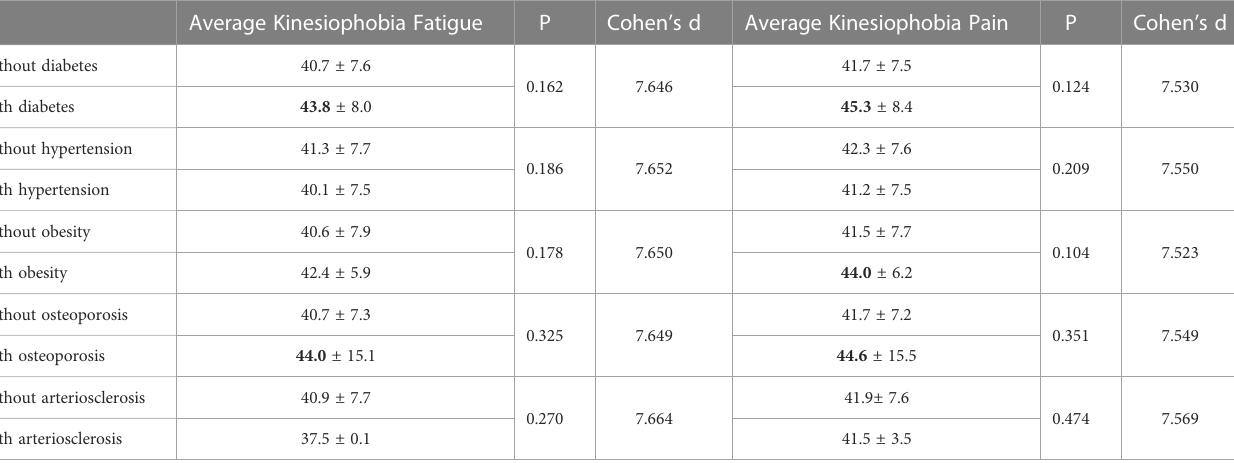
TABLE 8 Level of kinesiophobia and